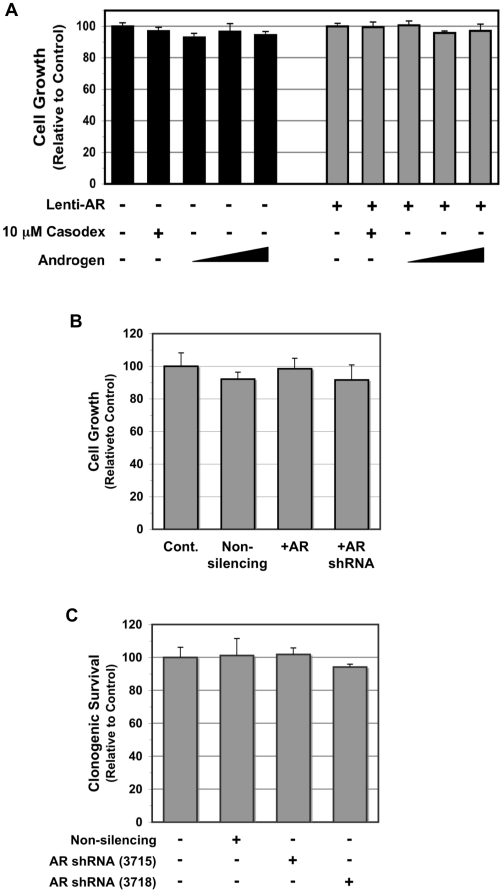
In vitro growth response to modulation of AR expression in E006AA cells.(A) Cell growth analyses of E006AA cells transduced with or without Lentiviral wild-type AR, which were then treated with 10 µM Casodex or an increasing dose of R1881 (1.0 nM to 100 nM). Cell growth is graphed relative to the respective untreated control cells. (B) Comparison of vector only Lentiviral-non-silencing, Lenti-AR, and Lenti-AR-shRNA transduced E006AA cell growth relative to control cells. (C) Colony forming assay comparing parental control cells to non-silencing, and two different anti-AR Lenti-shRNA sequences (3715 and 3718).